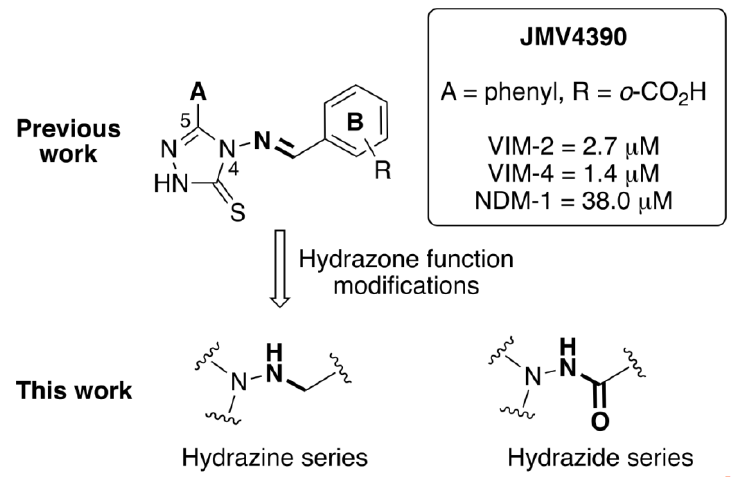
Figure 1. Previous work on hydrazone-like compounds and design of new stable series ( K i values are given for Schiff base JMV4390 (see the unpublished work in [37])).